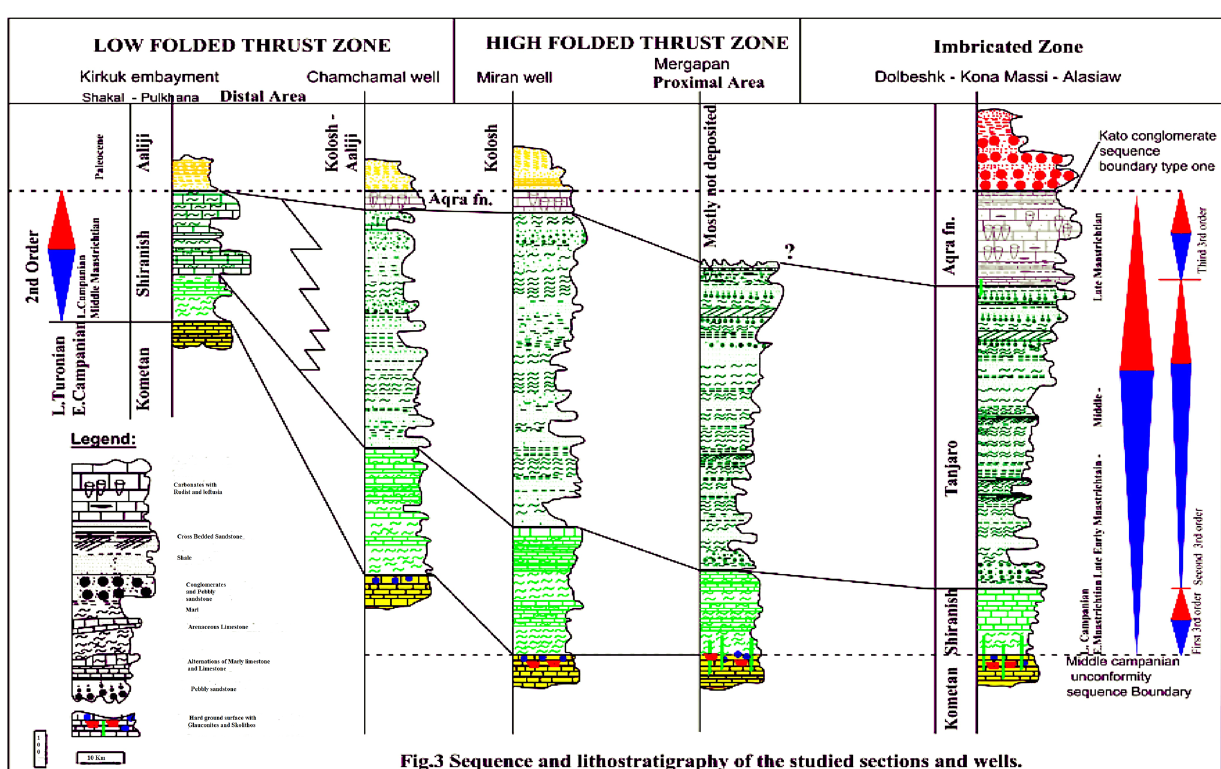
Fig. 8 Sequence and lithostratigraphy of the studied sections and